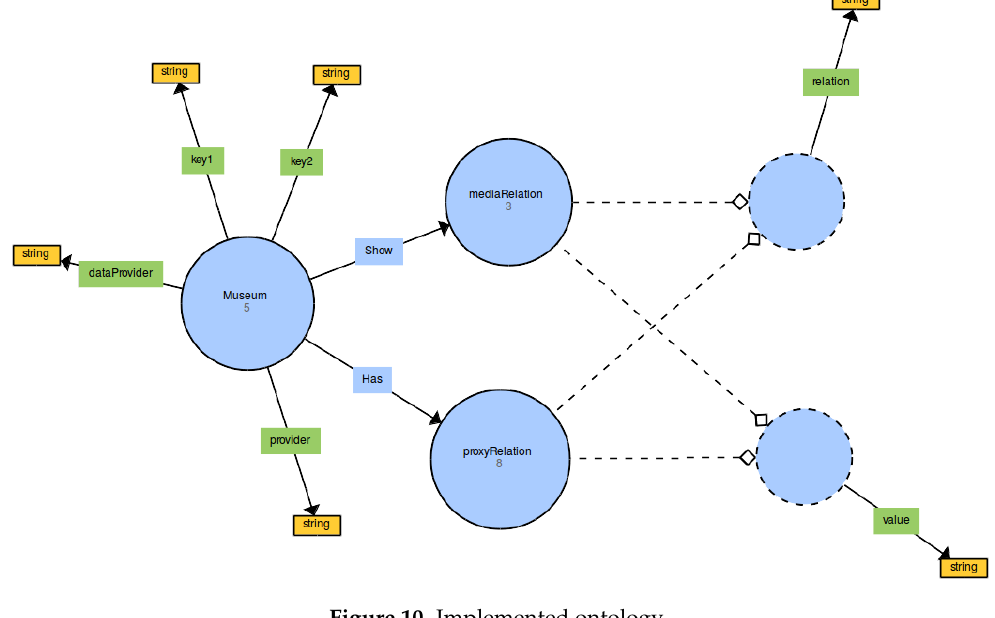
Figure 10. Implemented ontology.